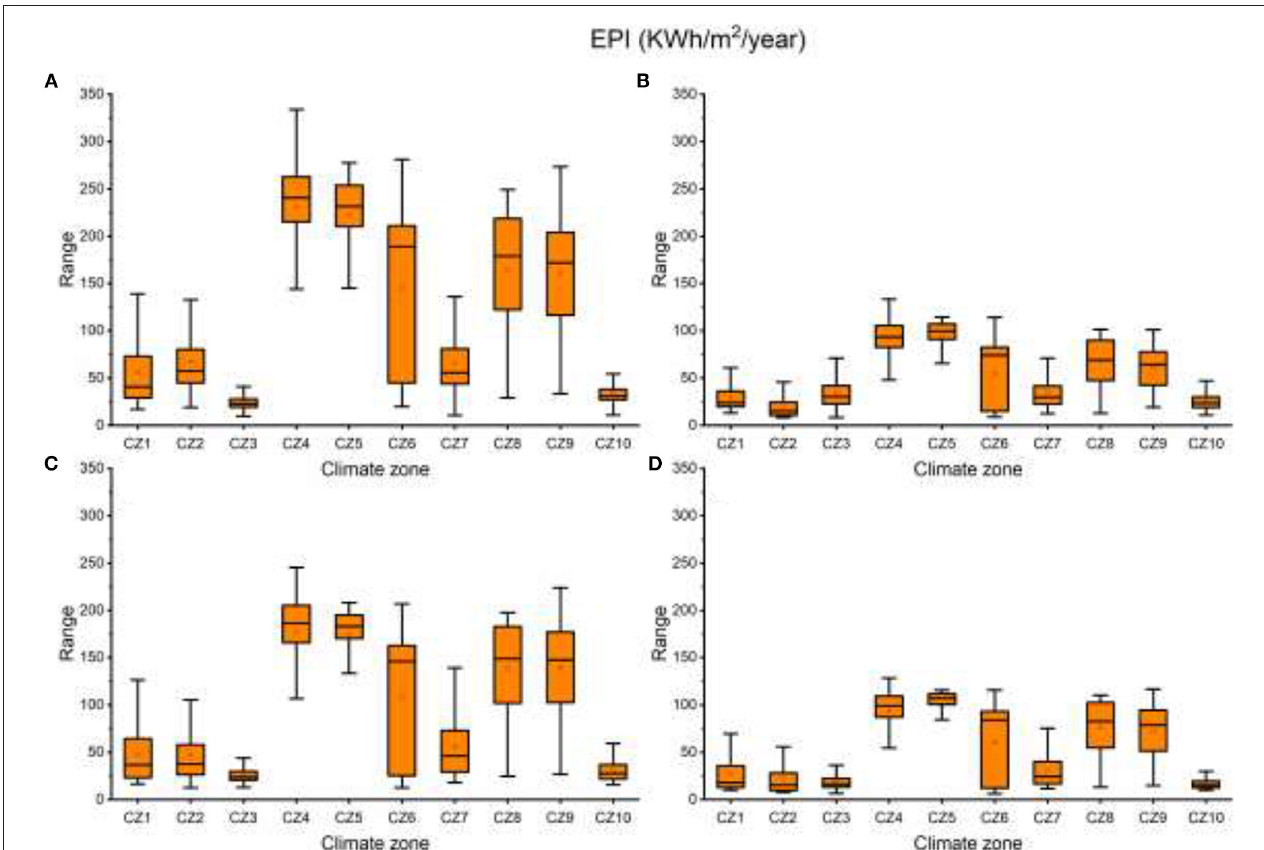
FIGURE 10 | Energy performance index (EPI) comparison (A) case 1a, (B) case1b, (C) case 2a, and (D) case 2b.